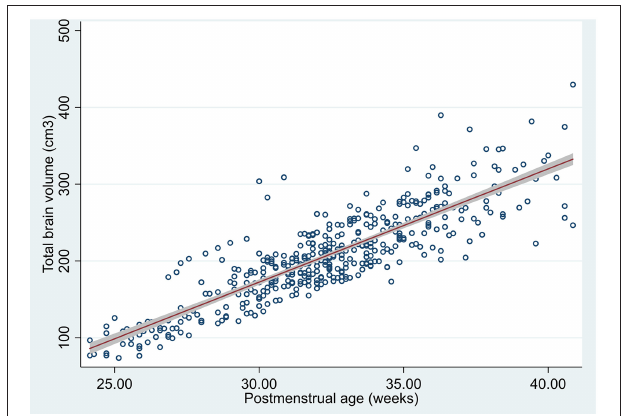
FIGURE 3 | Scatterplot of total brain volume by post-menstrual age segmented in 3D US, predicted mean and 95% confidence interval of the population means.